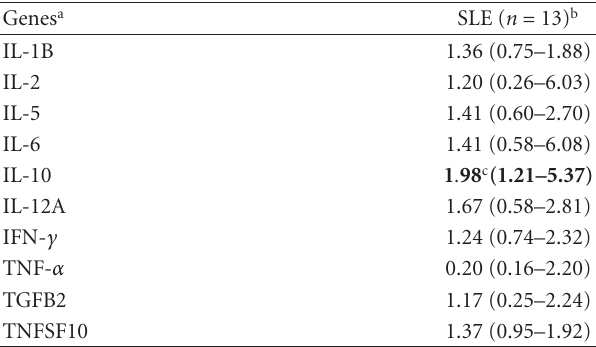
Table 3: Cytokines relative mRNA levels in